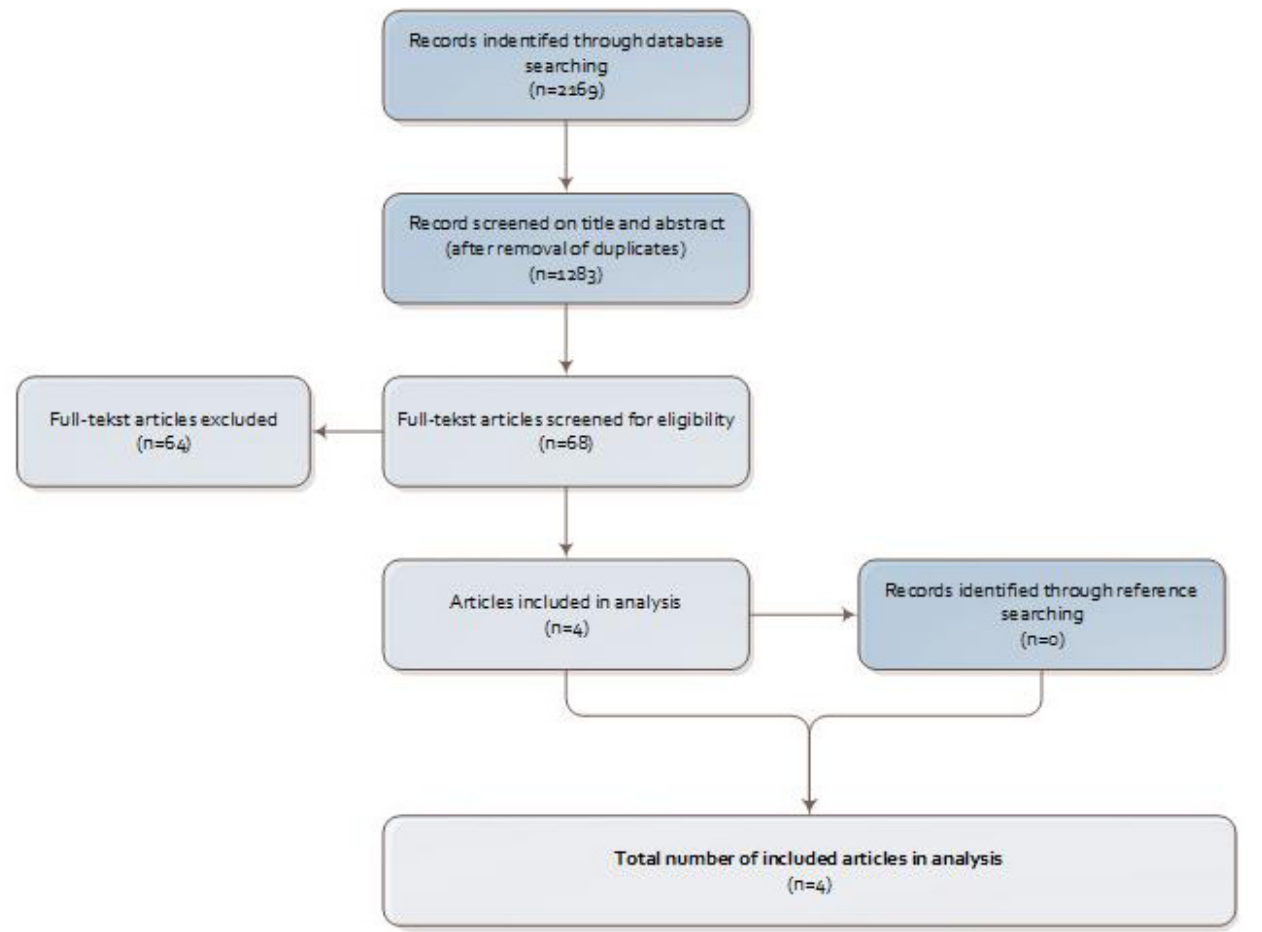
Figure 1. Study selection